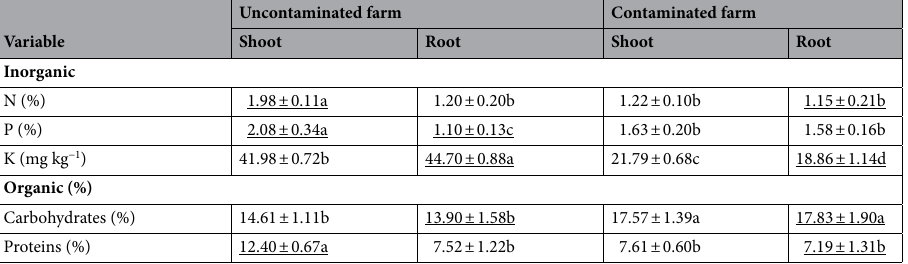
Table 3. Nutrient constituents in the shoots and roots ( N = 36 ) of the eggplants grown in uncontaminated and contaminated farms. Maximum and minimum values are underlined. Means with the same letters in the same raw are not significantly differed (Duncan’s multiple range tests at P < 0.05 ).